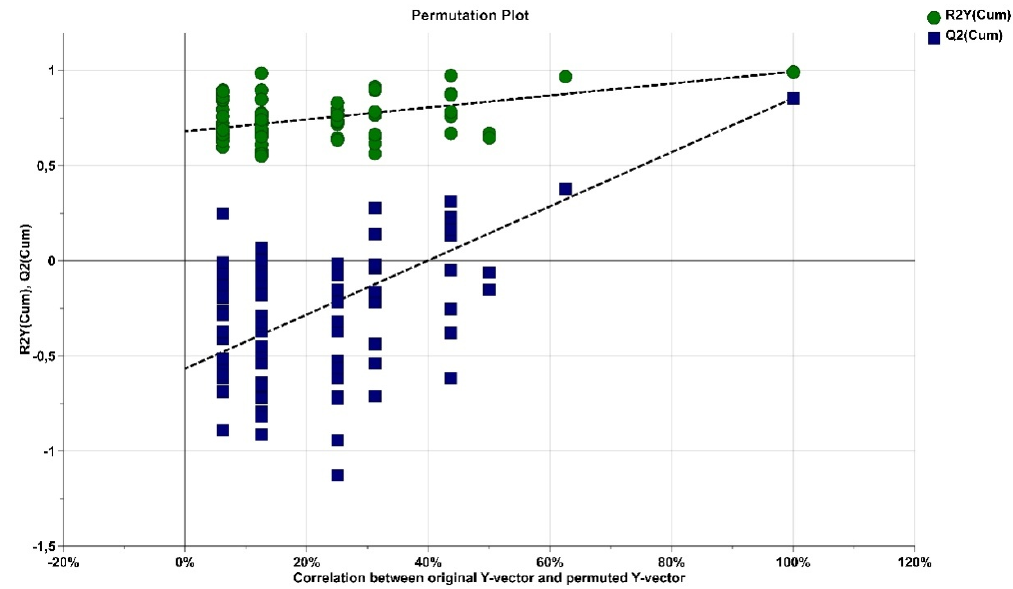
Figure 2. Permutation test plot for the OPLS-DA model (number of permutations, 200; Intercepts: R2 = 0.0, 0.669; Q2 = 0.0, −